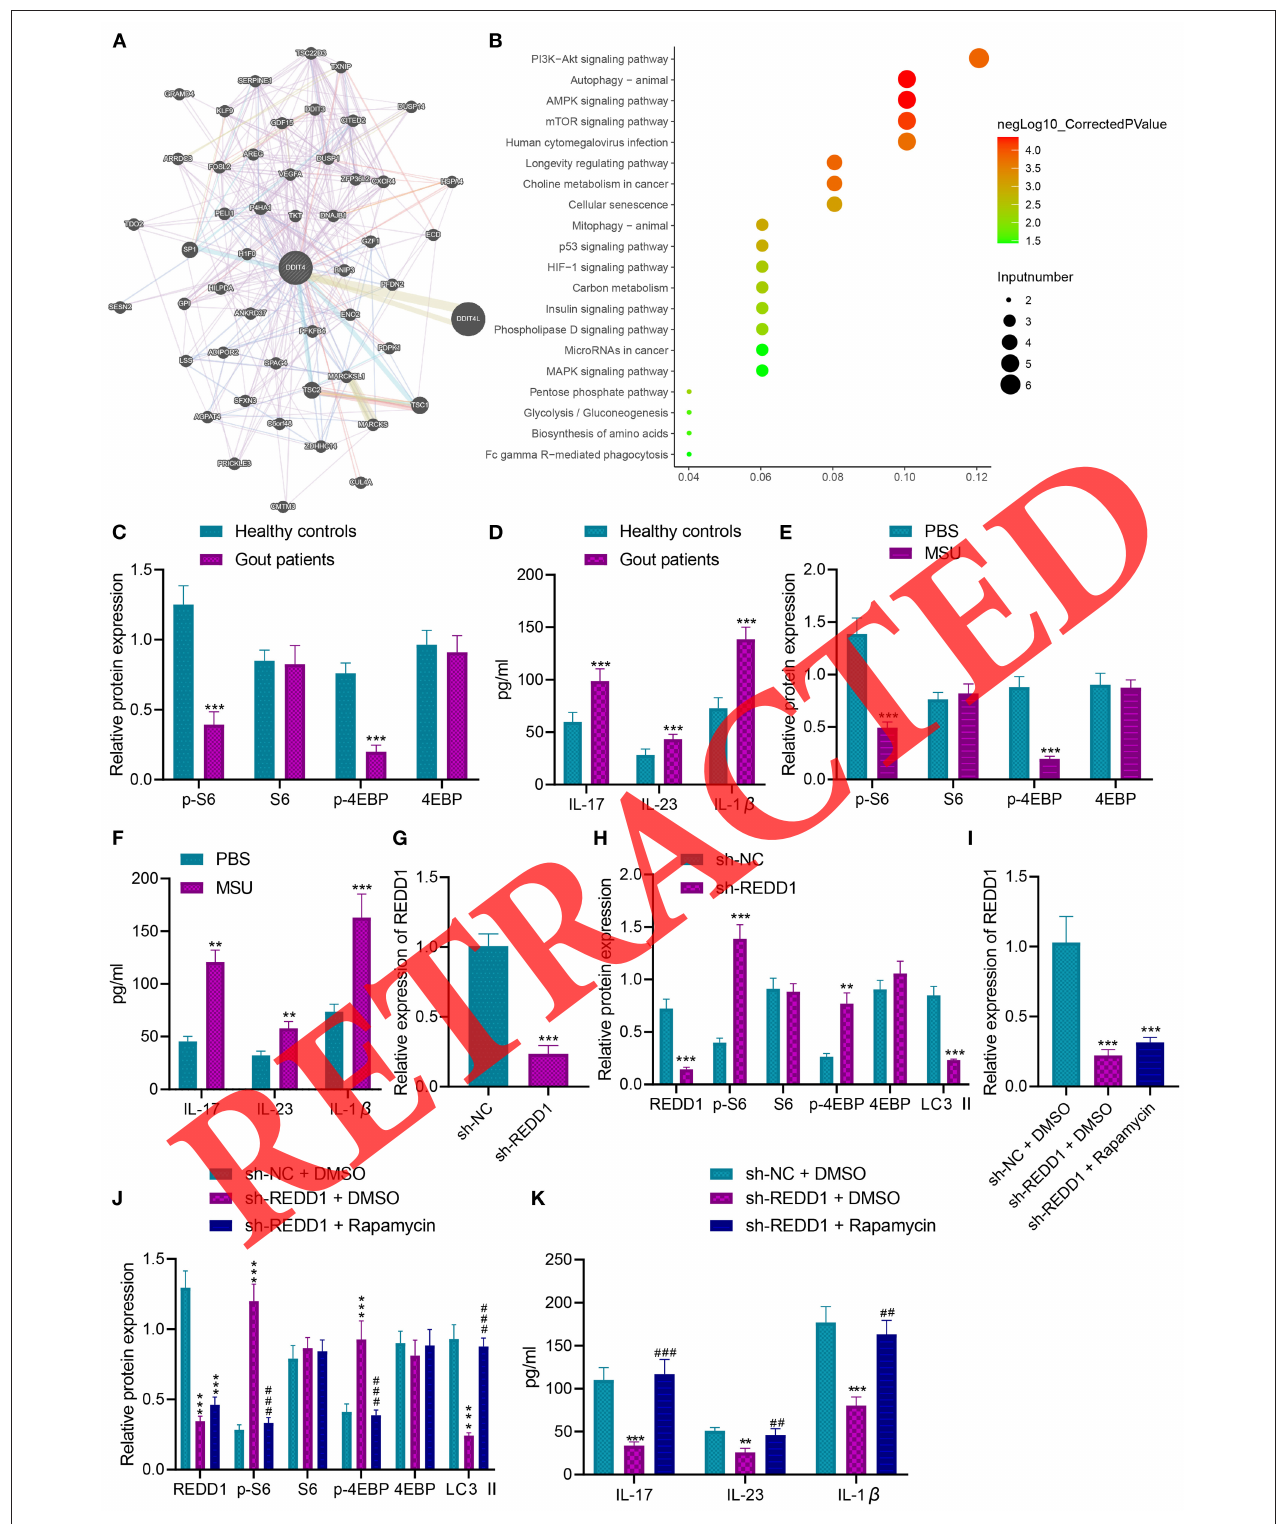
FIGURE 3 | REDD1 inactivates the mTOR pathway to trigger neutrophil autophagy and inflammatory response. (A) REDD1-related genes analyzed by the GeneMANIA database. Each circle in the figure represents a gene, and the line between circles indicates interaction between two genes. (B) KEGG